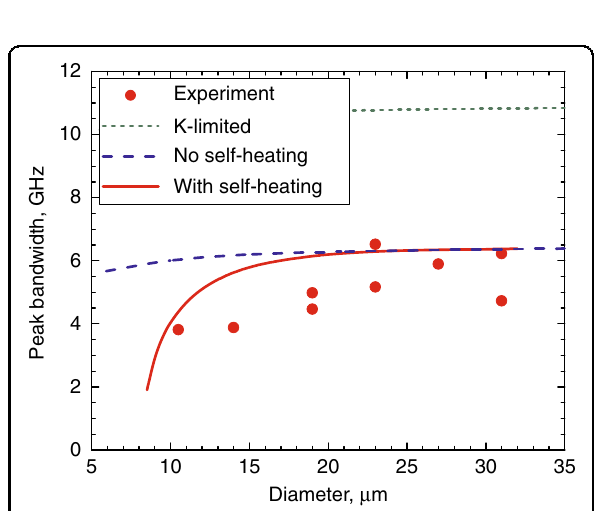
Fig. 15 Modulation bandwidths. Peak modulation bandwidth depending on the diameter of the QWD-on-GaAs microdisk laser: symbols — experiment, lines — modeling for different